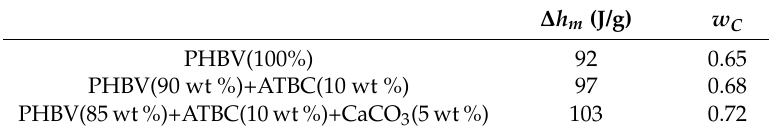
Table 3. Enthalpy of fusion ( ∆ h m ), and crystalline weight fraction ( w C ) for PHBV and PHBV mixed with ( i ) ATBC and ( ii ) ATBC and the mineral filler CaCO 3 (estimated errors: ± 1 J/g for ∆ h m , and ± 0.02 for w C